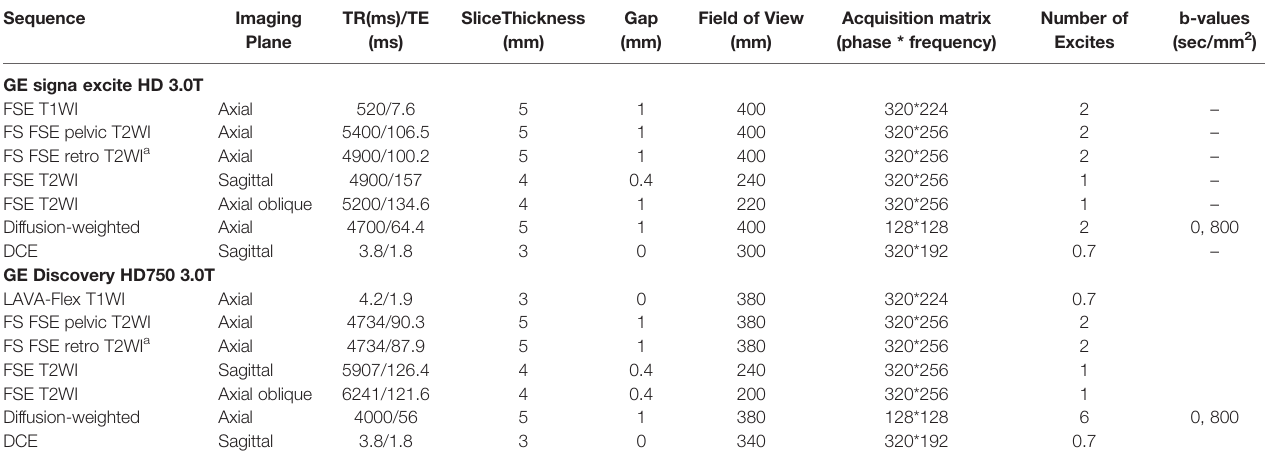
TABLE 1 | MR imaging